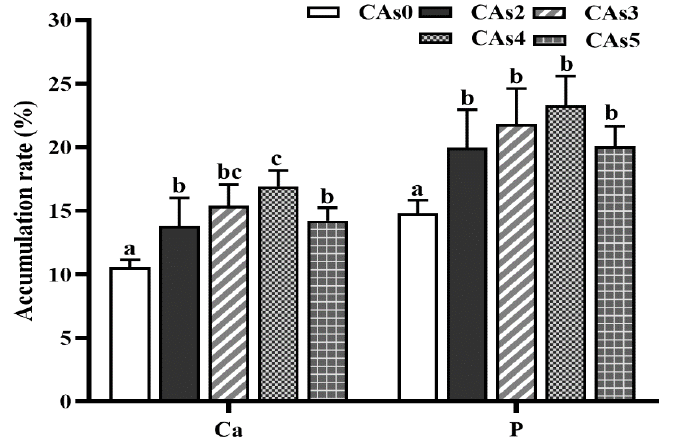
Figure 4. The accumulation rates of Ca and P of juvenile American eel in different CAs supplementation groups. a,b,c Different superscripts on the bar mean the significant differences ( p < 0.05).